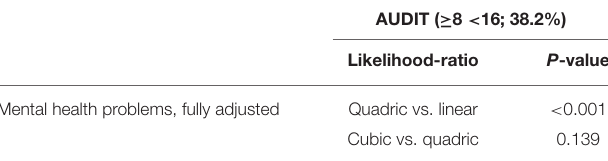
TABLE 6 | Likelihood-ratio test for the association between mental health problems and risky alcohol use after the removal of 2.5% of the respondents on each end of the HSCL-25